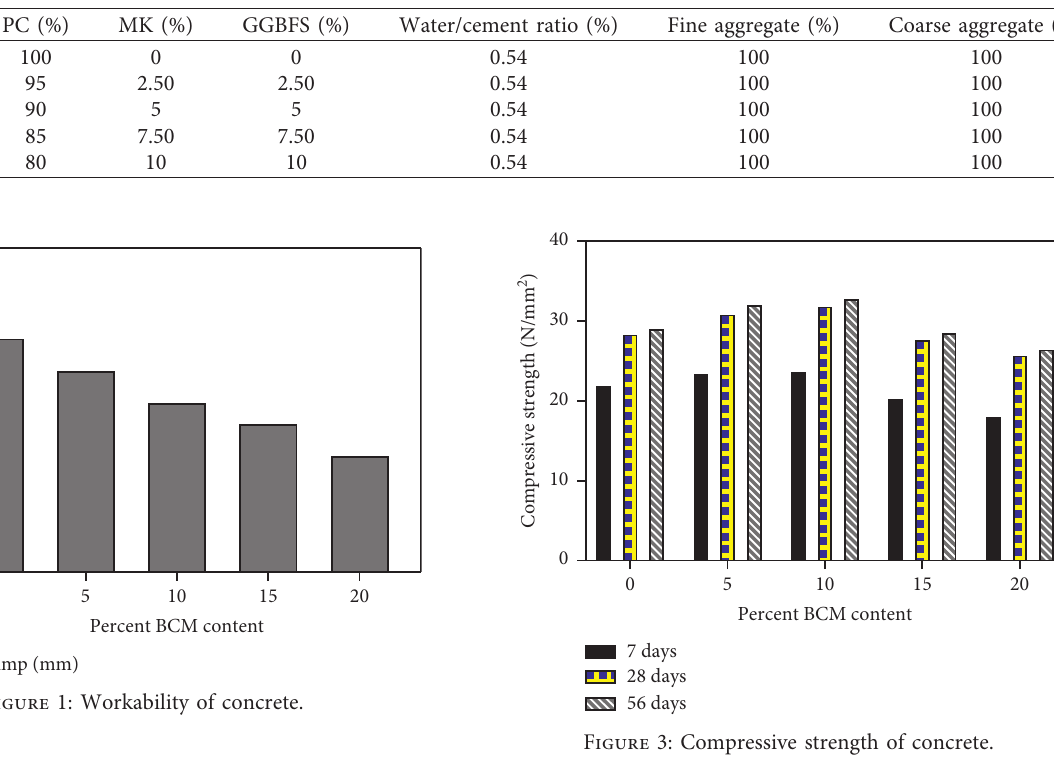
Table 3: Mixtures composition.